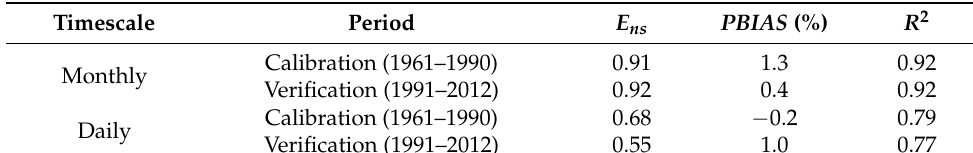
Table 2. Evaluation of the SWAT model’s performance for monthly and daily runoff simulation in the Fujiang River basin.